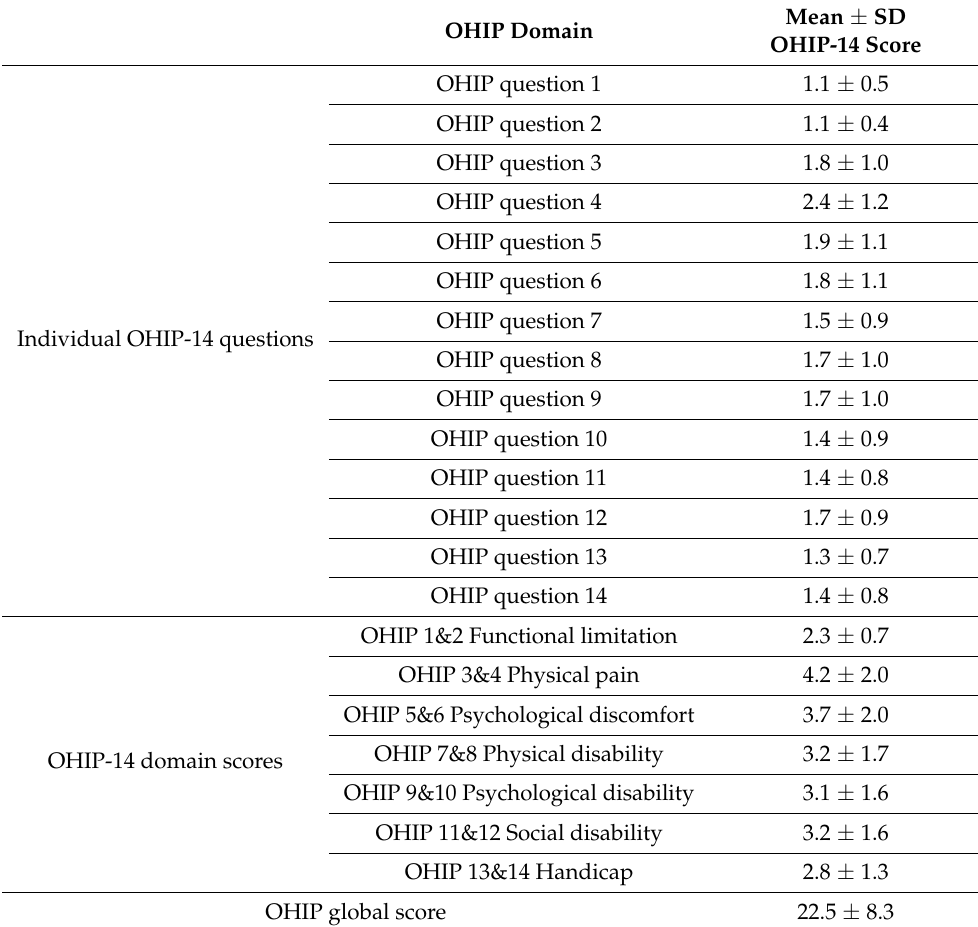
Table 3. Global and domain scores of pre-operative Oral Health Impact Profile-14 (OHIP-14) among the study